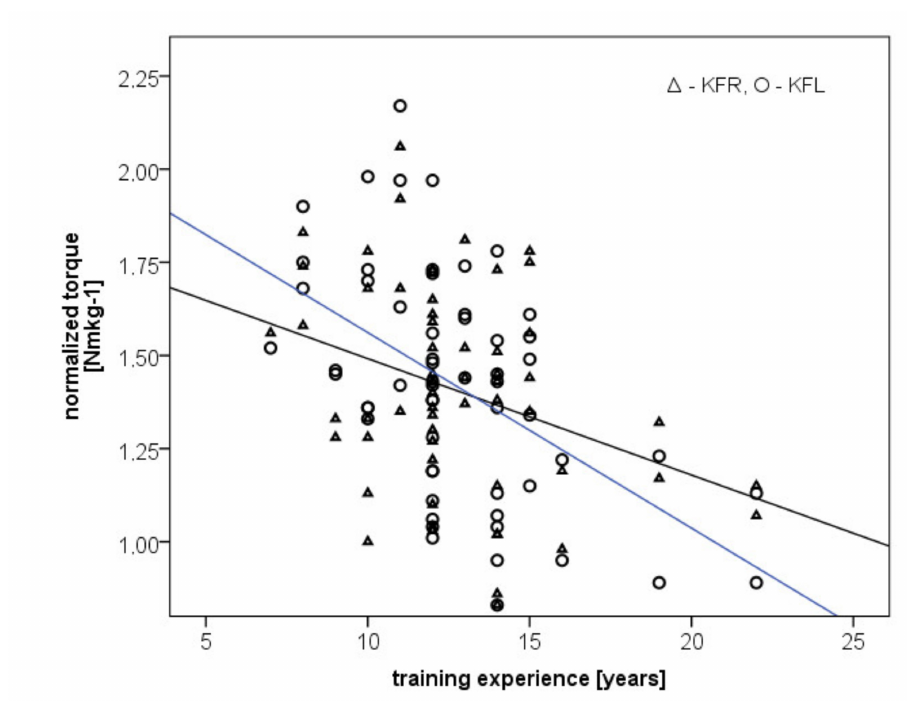
Figure 3. Correlation between normalized torque values of left and right leg flexors and training experience in